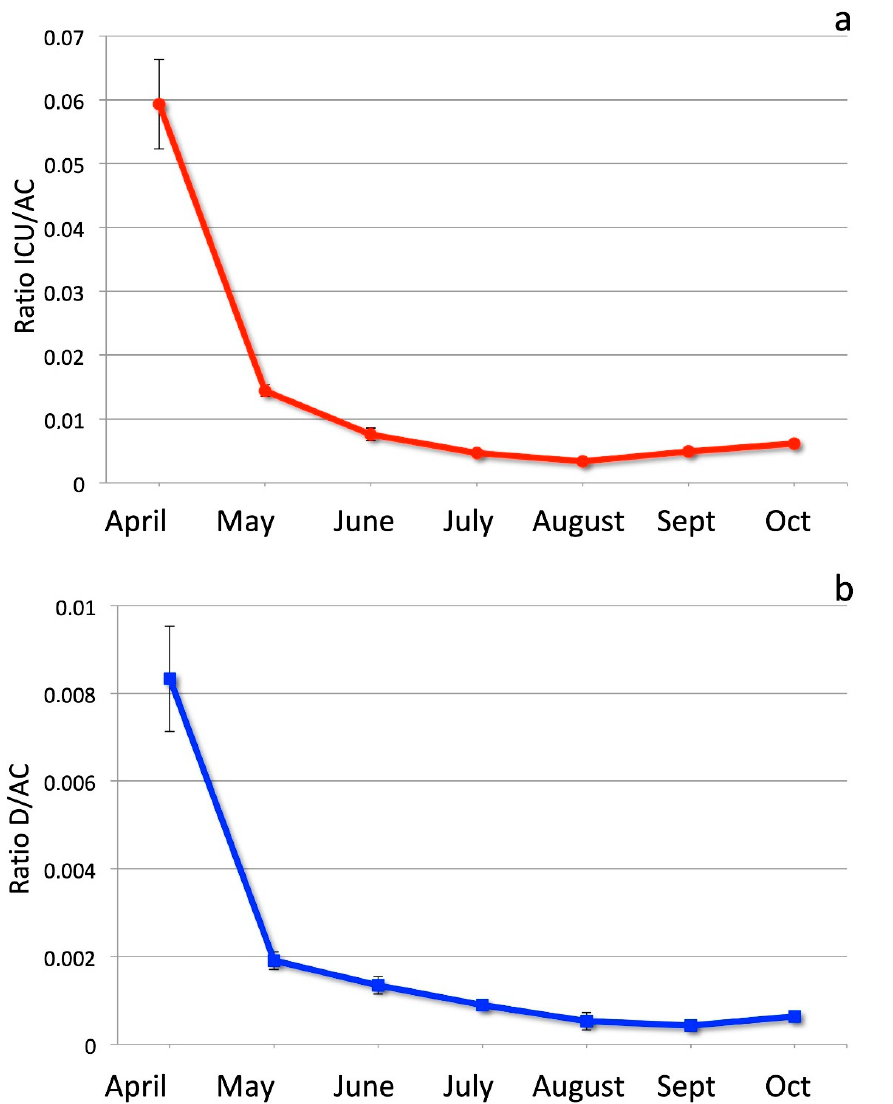
Figure 1. ( a ) Ratio between ICU occupation and active cases in each month, from April to October. Error bars are as in Table 1 (statistical errors at 95% probability level, i.e., two standard deviations). ( b ) Ratio between deaths and active cases in each month, from April to October. Error bars are as in Table 1 (statistical errors at 95% probability level, i.e., two standard deviations).